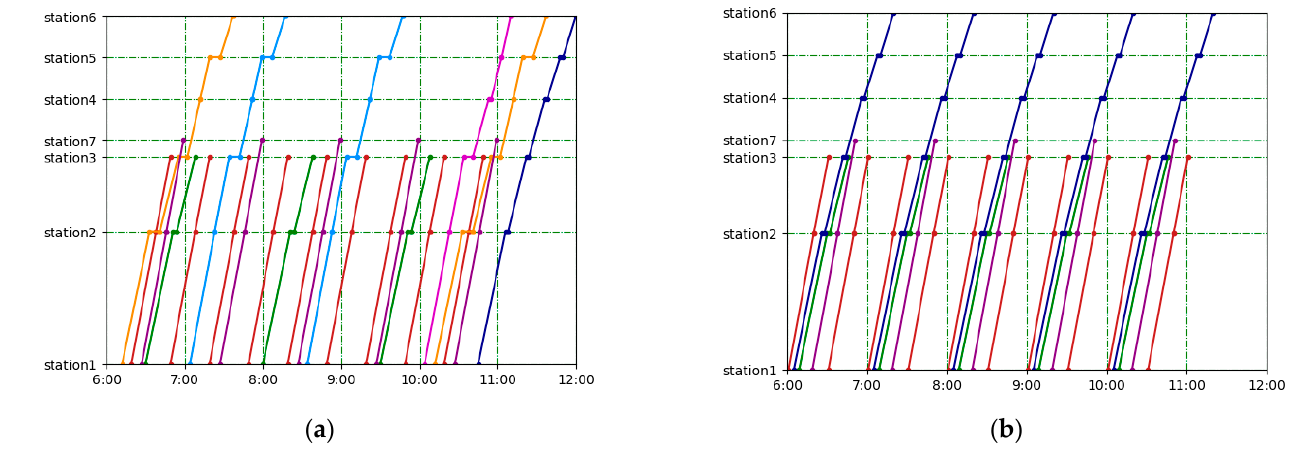
Figure 8. Multi-cycle train timetable and single-cycle train timetable under scenario 3. (a) Multi-cycle train timetable. (b) Single-cycle train timetable. Red, green, blue, orange, violet, navy blue and purple represents Line 1, 2, 3, 4, 5, 7 and 10 in Table 3, respectively.